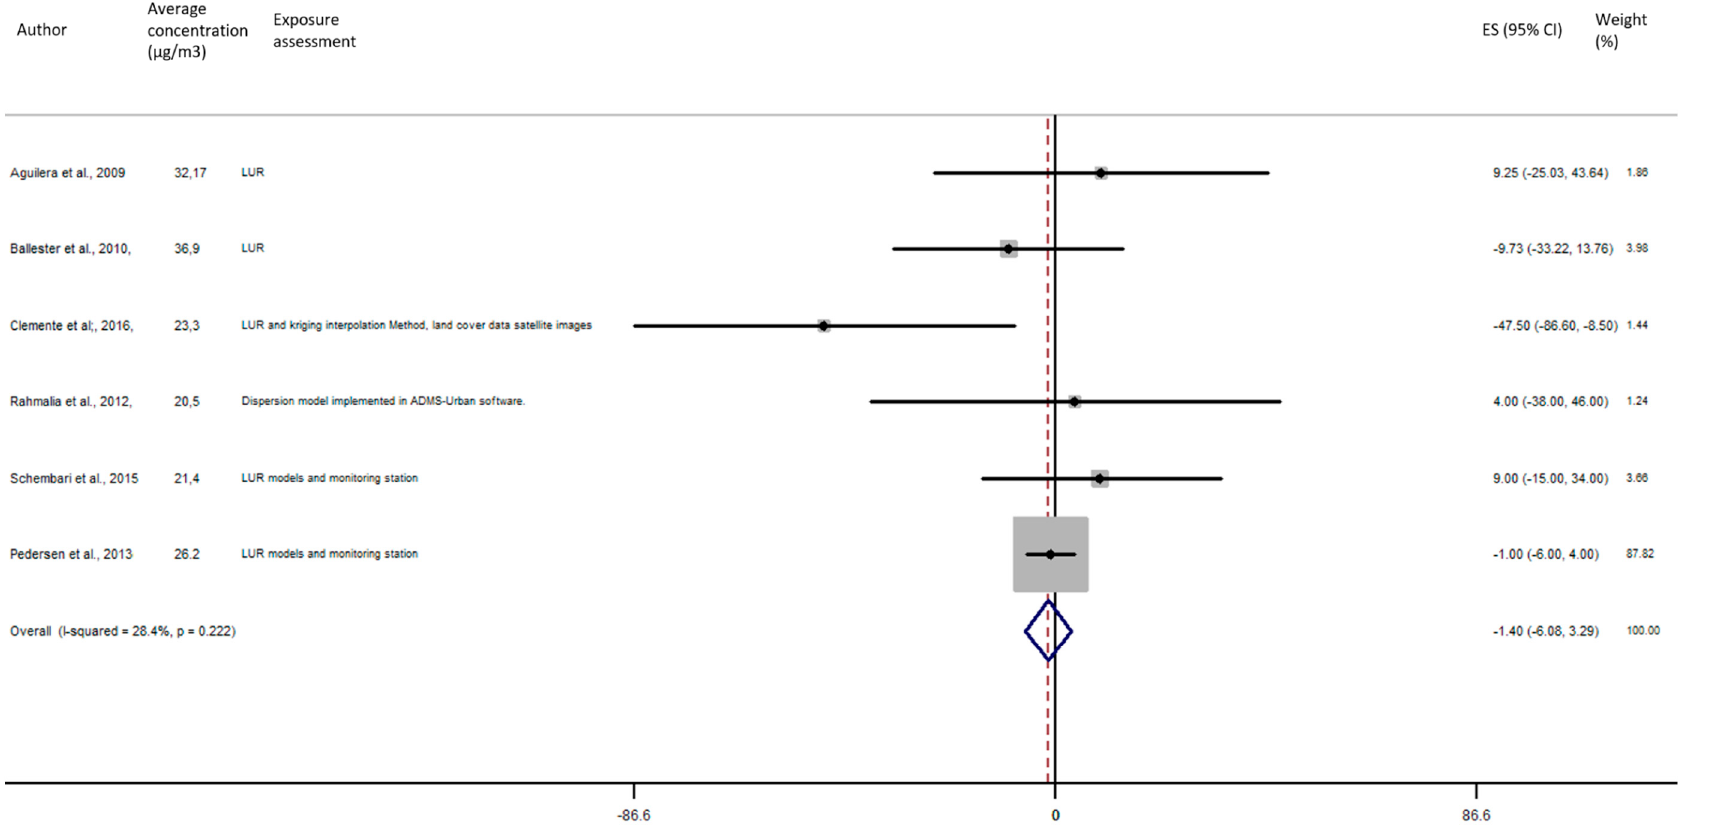
2 exposure during the entire